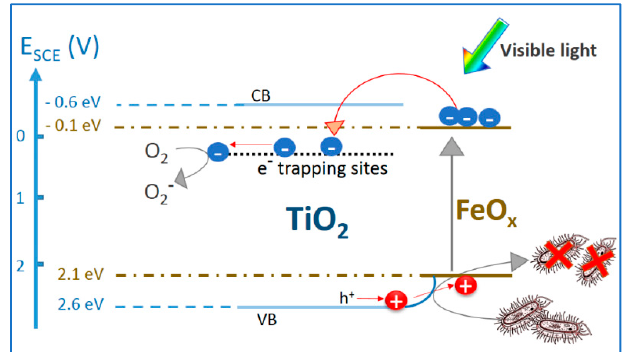
Figure 2. Interfacial charge transfer (IFCT) electron transfer between FeO x and low-lying TiO 2 trapped states under visible light irradiation (>404 nm). Reprinted with permission from [28]. Copyright 2017 Elsevier.